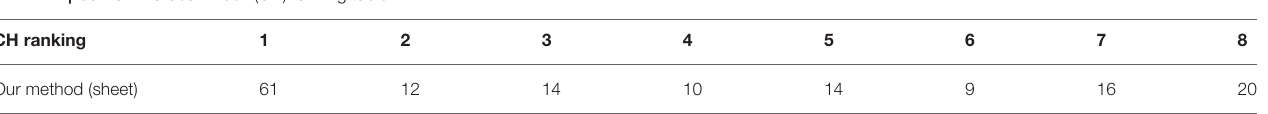
TABLE 1 | Calinski-Harabaz index (CH) ranking table. CH ranking